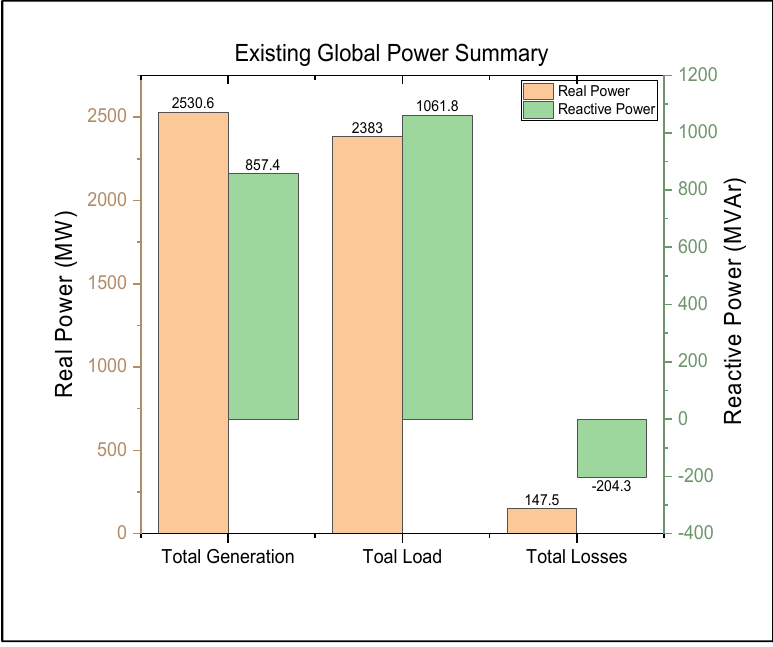
Figure 9. Figure showing the global power summary for the existing network.